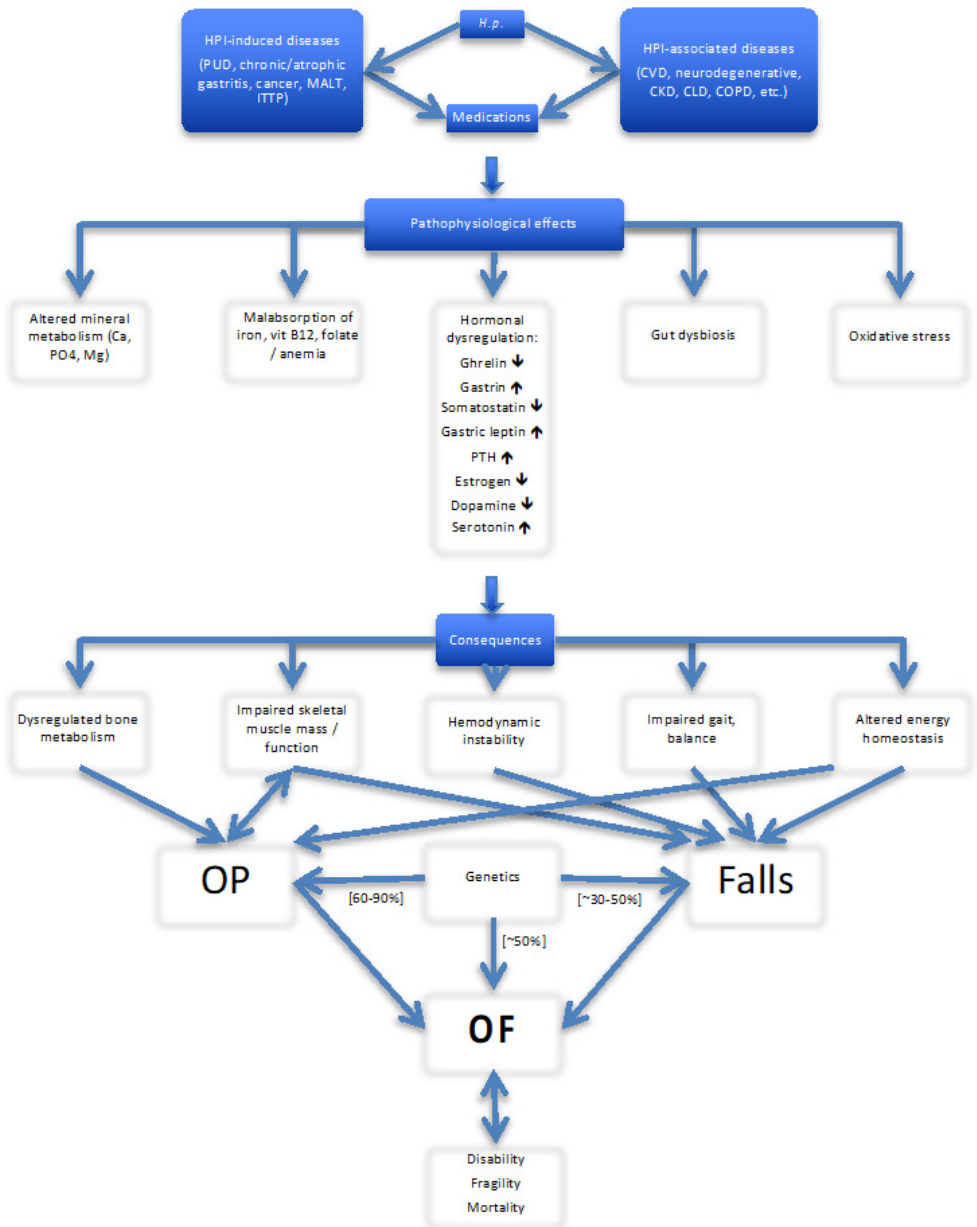
Figure 2. Schematic representation of Helicobacter pylori infection (HPI)-related factors and main pathophysiologic mechanisms that may lead to osteoporotic fractures. Abbreviations: Up-arrows refer to elevation/stimulation, down-arrows refer to reduction/decrease; Ca, calcium; CKD, chronic kidney disease; CLD, chronic liver disease; COPD, chronic obstructive pulmonary disease; CVD, cardiovascular disease; H.p., Helicobacter pylori ; ITT, idiopathic thrombocytopenic purpura; MALT, mucosa-associated lymphoid tissue B-cell lymphoma; Mg, magnesium; OF, osteoporotic fracture; OP, osteoporosis; PO 4, phosphate; PTH, parathyroid hormone; PUD, peptic ulcer disease. Notes: HPI- and concomitant treatment-induced changes in gastric structure and functions affect nutrient absorption (calcium, phosphate, magnesium, iron, vitamin B12, folate, etc.), production of gastric / gut (ghrelin, gastrin, histamine, somatostatin, leptin, estrogens, dopamine, serotonin and incretins) and systemic hormones (PTH and sex hormones) and cause gut dysbiosis. These alterations (via direct and / or indirect mechanisms) result in dysregulated bone-mineral metabolism, impaired skeletal muscle mass, function, gait and balance, hemodynamic instability and altered energy homeostasis increasing the risks for